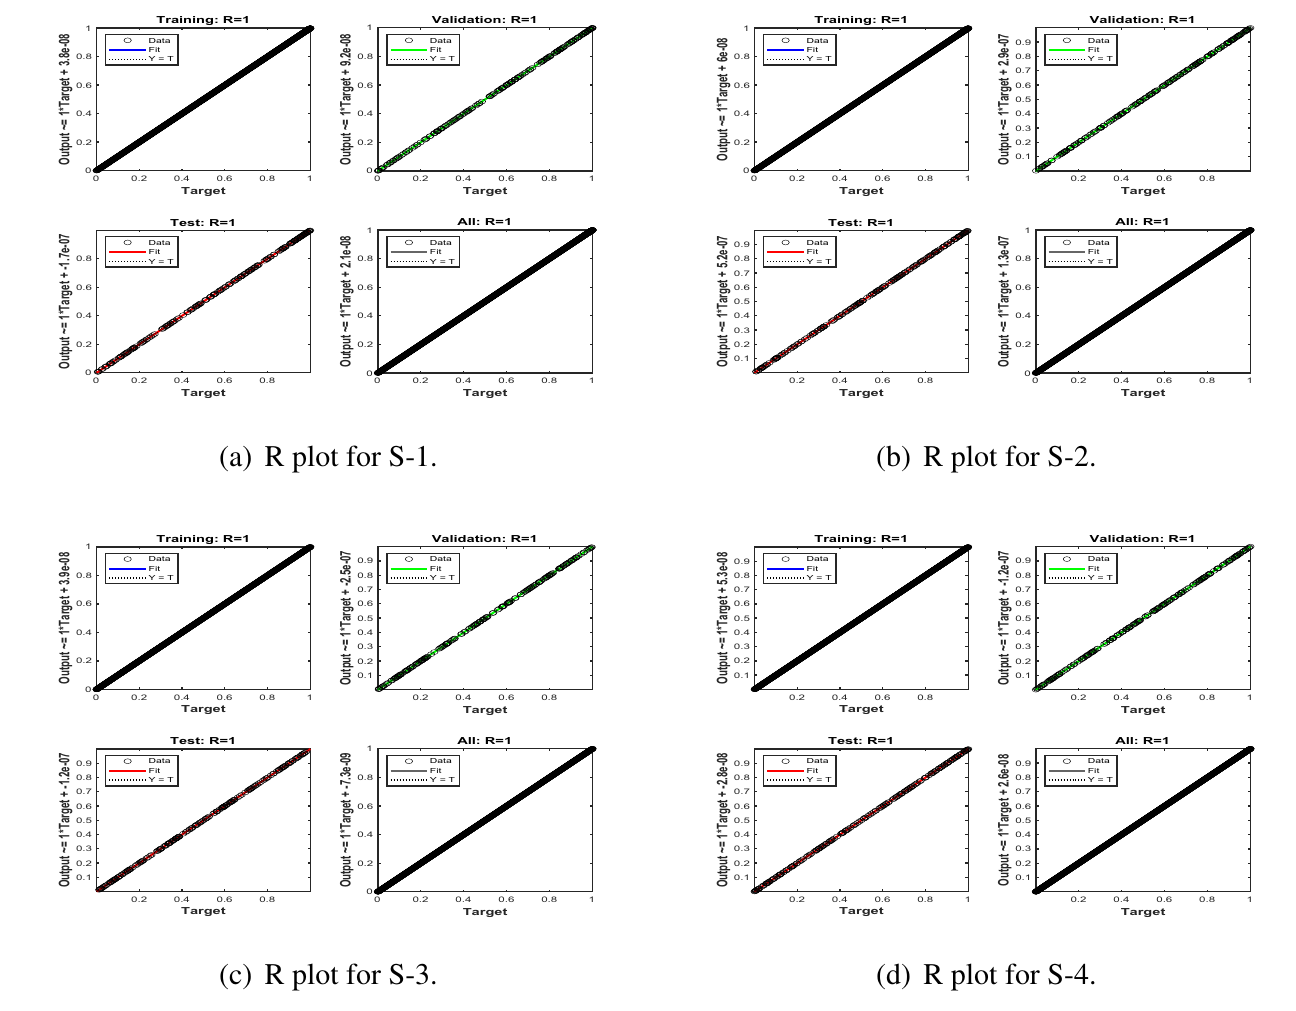
Figure 14. Regression (R) views of LMA-TNN results for Case 2 in Vogel’s